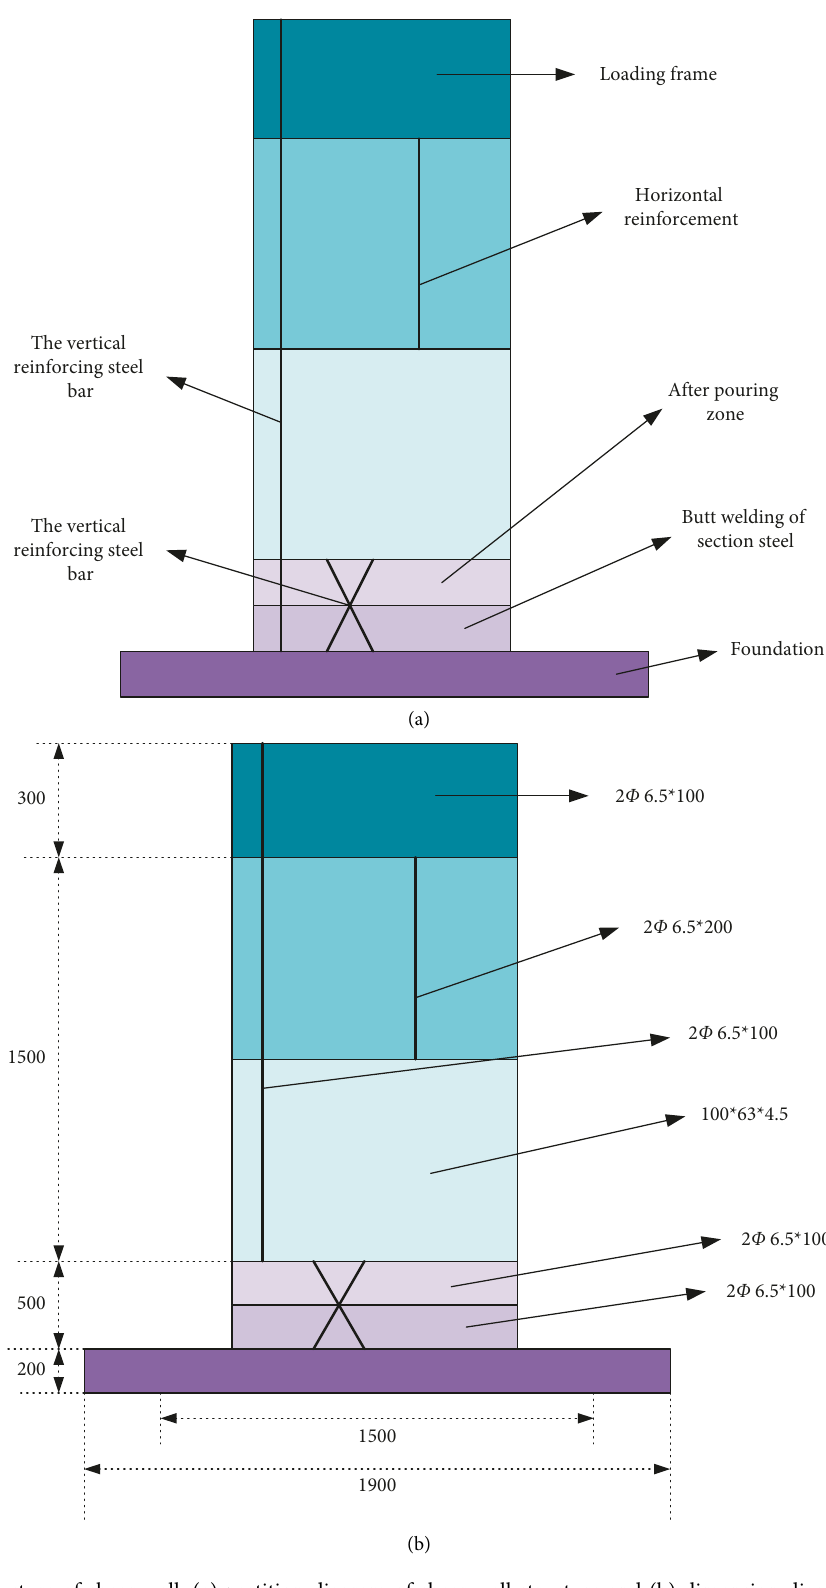
Figure 4: Internal structure of shear wall: (a) partition diagram of shear wall structure and (b) dimension diagram of shear wall